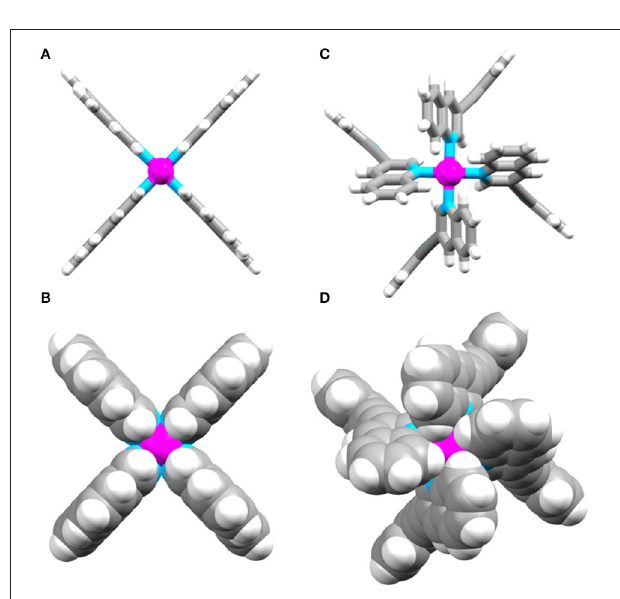
FIGURE 6 | Top down views of (A) and (B) the DFT optimized model of C iq , and (C) and (D) the X-ray structure of C q . To assess biological activity, the cytotoxic effect (as half- maximal inhibitory concentrations (IC 50 )) of the ligands and cages were determined against three different cell lines: cisplatin resistant MDA-MB-231 (breast cancer) (Lehmann